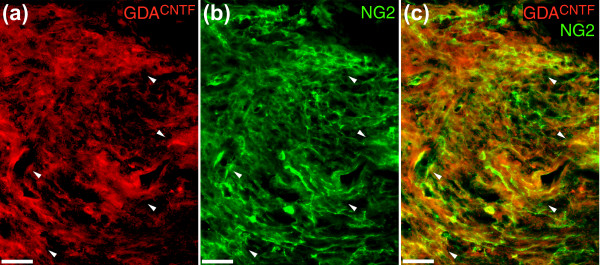
NG2 immunoreactivity in GDACNTF-transplanted dorsal column injuries. (a) Transplanted hPAP+ GDAsCNTF (arrowheads) at 8 days post injury/transplantation. (b) The same slide stained for NG2 (green) showing that the transplanted cells (arrowheads) show immunoreactivity for NG2. (c) Co-localization (yellow) of NG2 and hPAP immunoreactivity in regions containing higher densities of GDAsCNTF (arrowheads). In general, regions of the injury site that contained higher densities of hPAP+ GDAsCNTF had a higher density of NG2 immunoreactivity. Scale bars 50 μm.